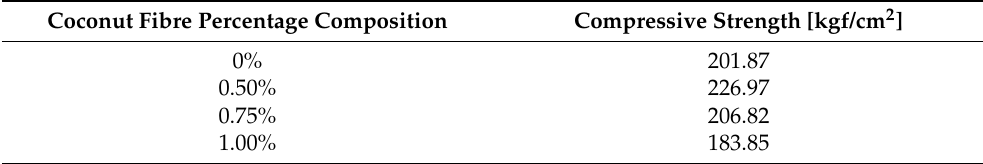
Table 7. Compressive strength of cylinders and flexural tensile strength of beams.